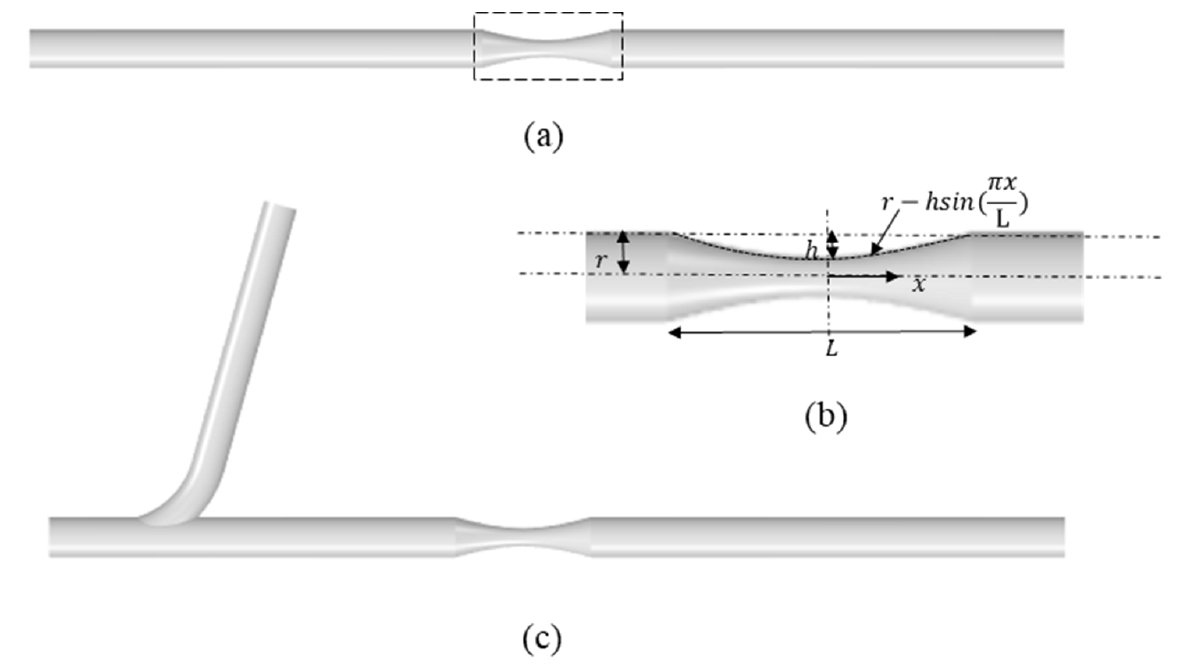
Figure 1. Geometric representation of the idealized stenosed artery model: ( a ) Model without side branch. ( b ) Profile of the stenosis. ( c ) Model with side branch.